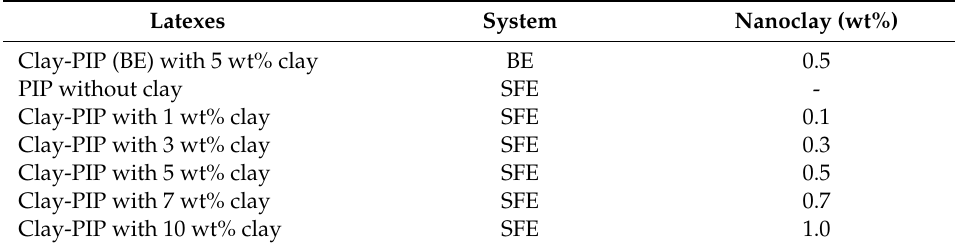
Table 1. Synthesizing recipes of polyisoprene (PIP) and Clay-PIP Latexes containing various nanoclay contents. Two techniques were employed: batch (BE) and starve-fed (SFE) emulsion polymerizations.